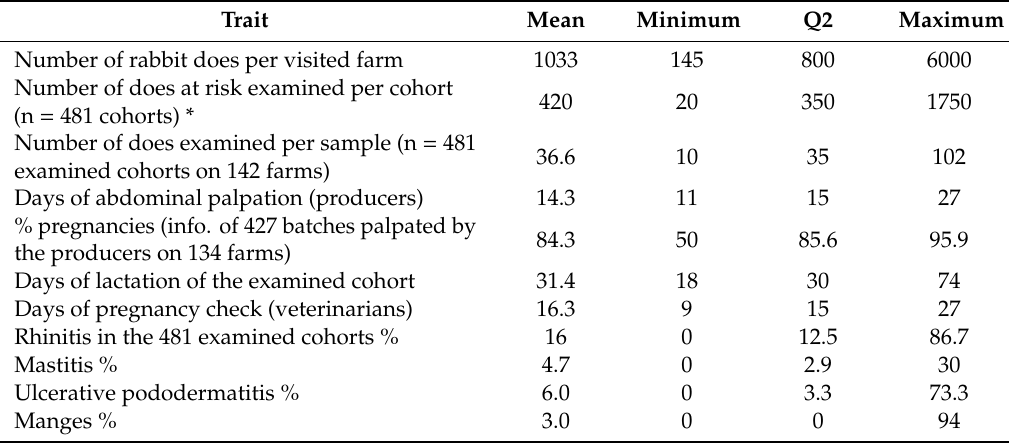
Table 4. Traits of the farms and cohorts sampled in Spain, between November 2014 and December 2019.